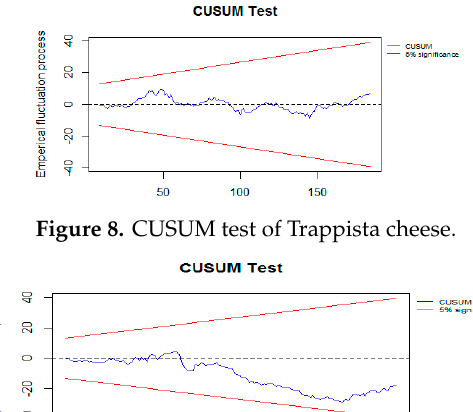
Figure 7. CUSUM test of natural yogurt.